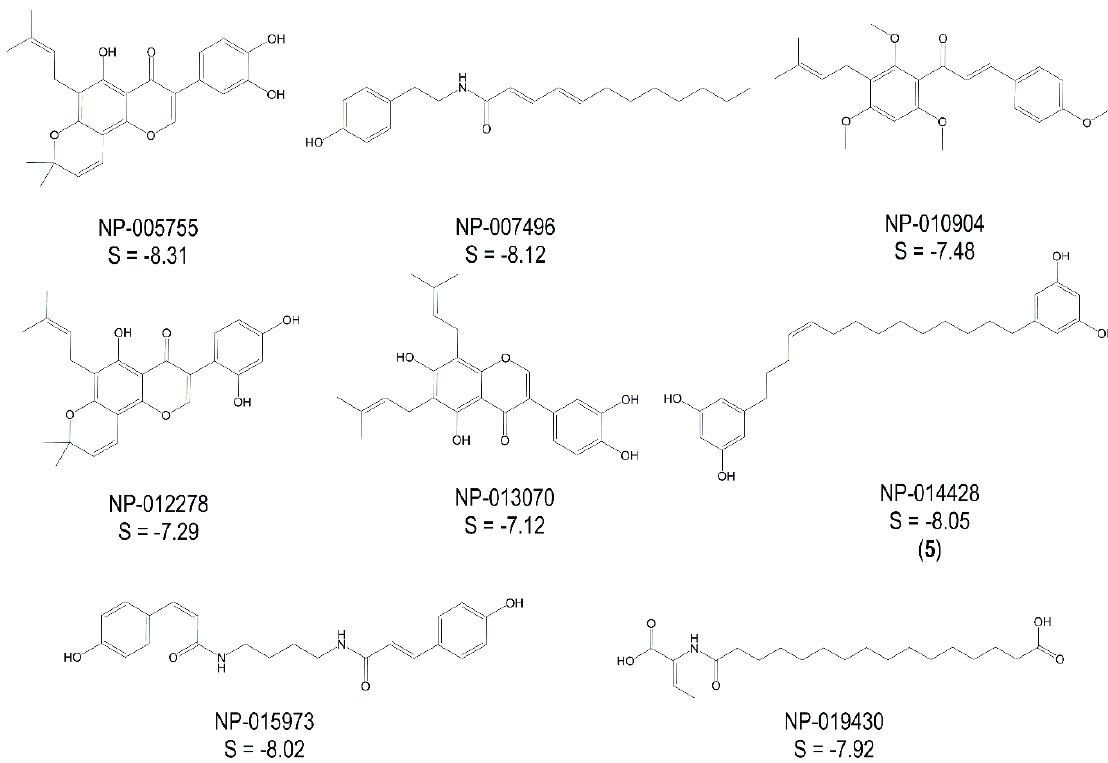
Figure 2. Best hits from the virtual screening based on the NAD + pharmacophores; S-scores of the docking experiments (induced-fit approach) are given in kcal/mol; a “self-docking” computation of the cosubstrate was performed accordingly (S NAD+ = − 9.10